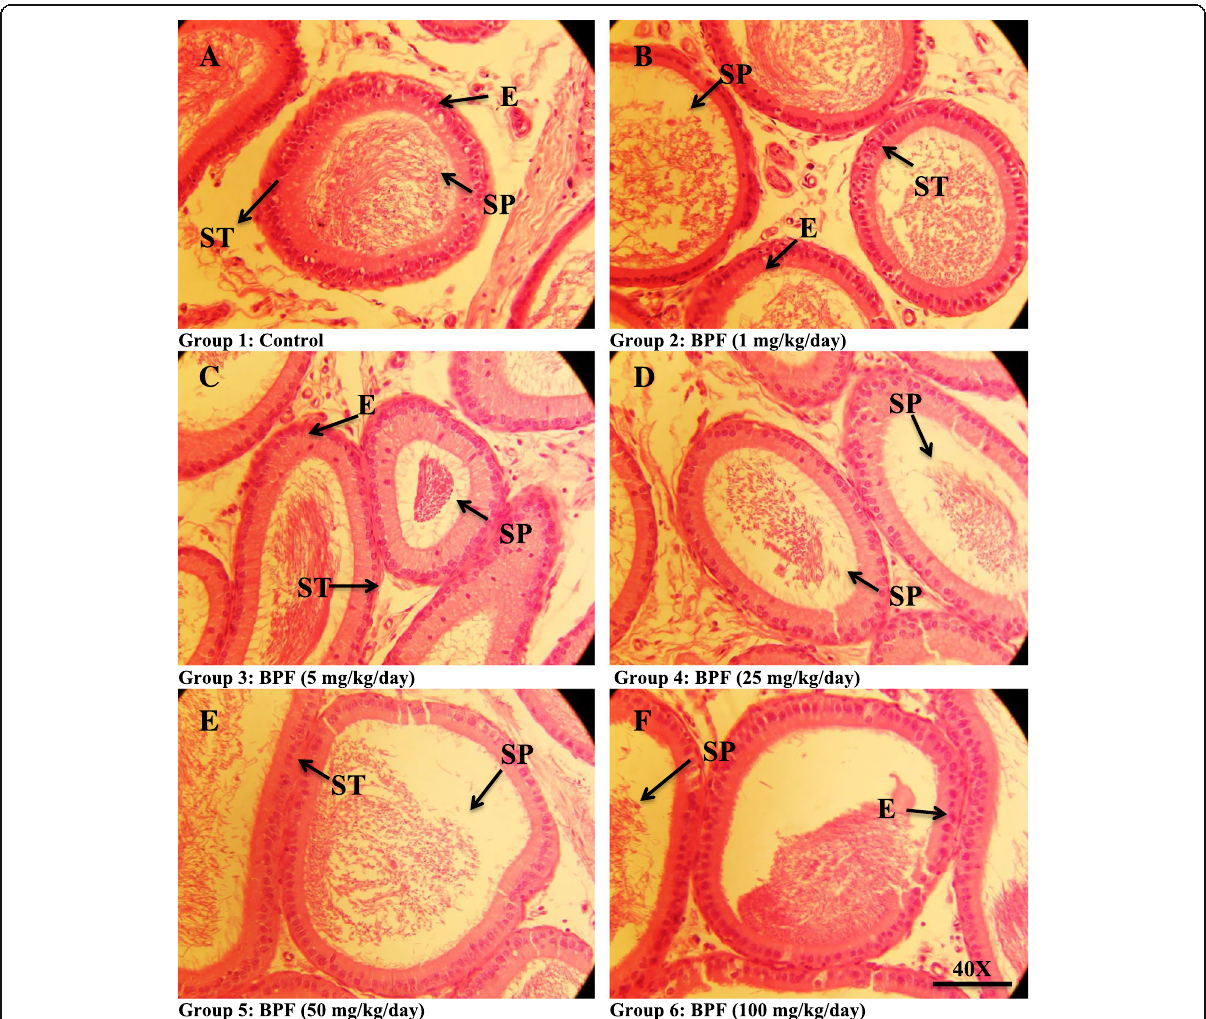
Fig. 2 Photomicrograph of caput epididymis tissue showing a control; with compact arrangement of caput tubules with sperm-filled lumen b BPF (1 mg/kg/day)-exposed group, presenting normal caput tubules like in the control. c BPF (5 mg/kg/day) exposed group showing seminiferous tubules with less number of sperm in the lumen (arrow). d BPF (25 mg/kg/day)-exposed group presenting caput tubules with empty lumen (arrow). Similarly, e BPF (50 mg/kg/day)-exposed group showing less number of sperms in the lumen. f BPF (100 mg/kg/day)-exposed group showing less number of sperms and empty lumen (arrow). Presenting SP, spermatozoa; ST, seminiferous tubules; E, epithelium. H&E (×